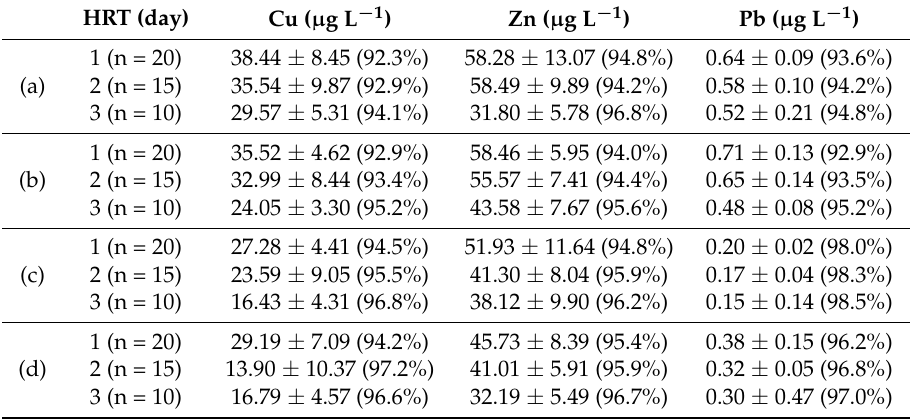
Figure 4. Removal efficiencies (%) for heavy metals at different HRTs (day). Vertical error bars present standard deviation. ( A ) Cu removal; ( B ) Zn removal; and ( C ) Pb removal. Table 4. The mean effluent concentrations (mg L − 1 ), removal efficiencies (%) and standard deviations (SD) (±) of heavy metals for bioretention mesocosms.